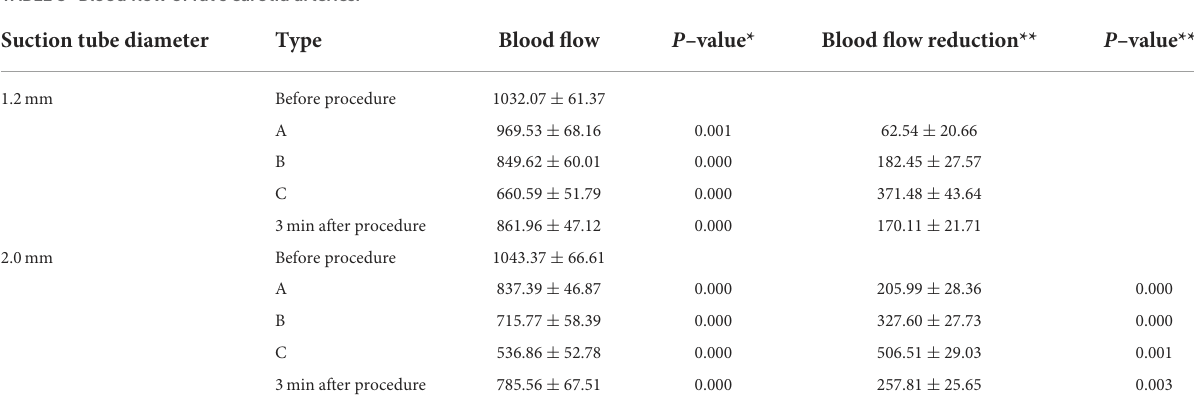
TABLE 3 Blood flow of rat’s carotid